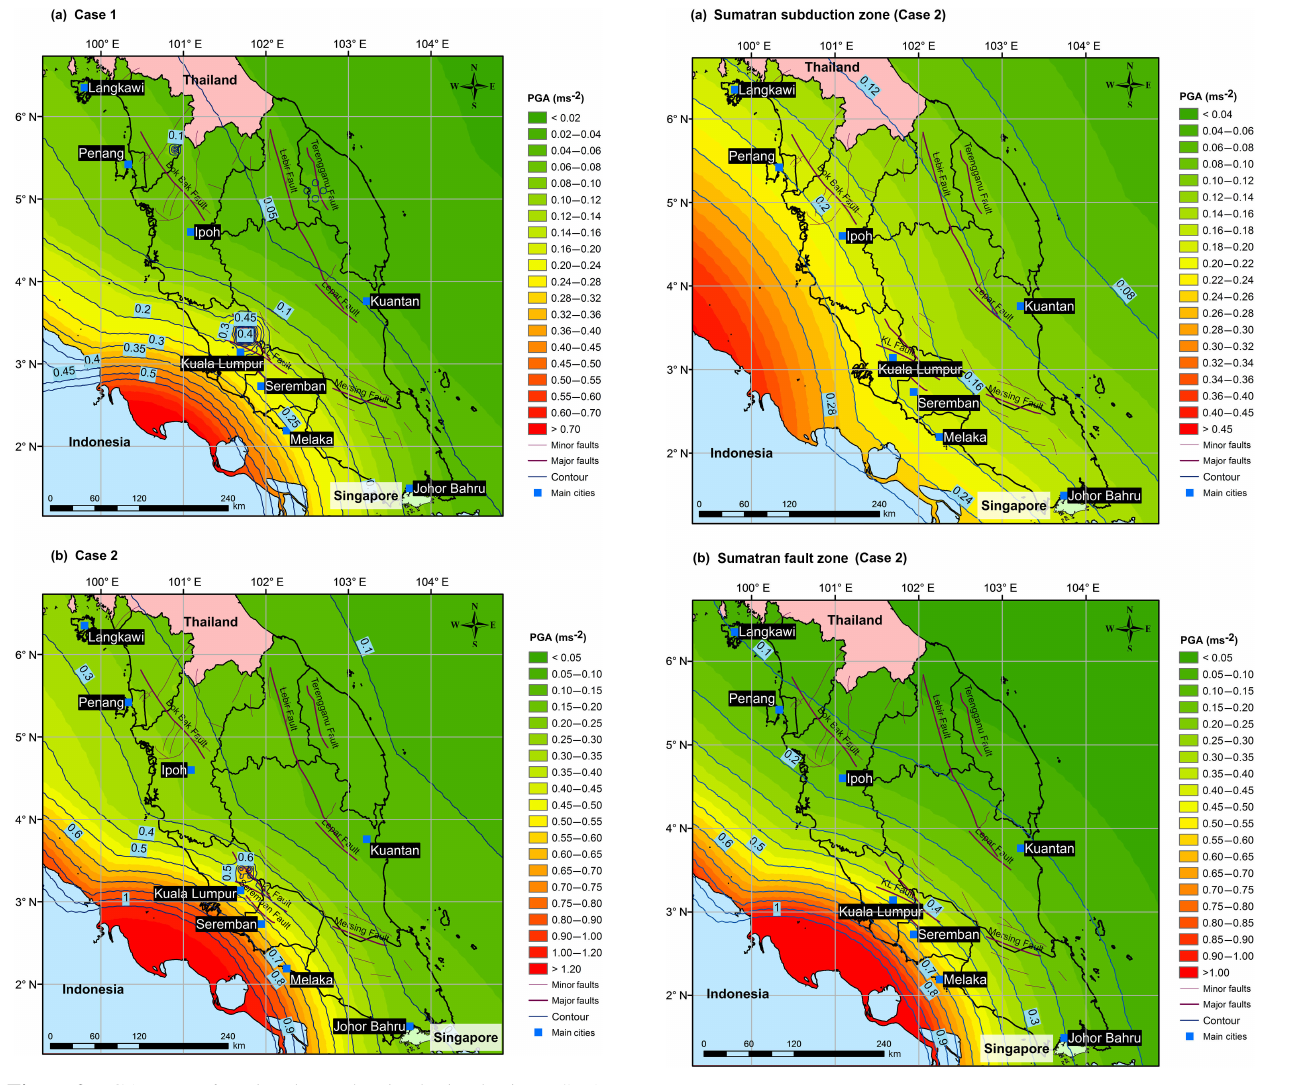
Figure 10. PGA maps of Peninsular Malaysia for Case 2 for the sources originating from (a) Sumatran subduction zone and (b) Sumatran fault zone based on Case